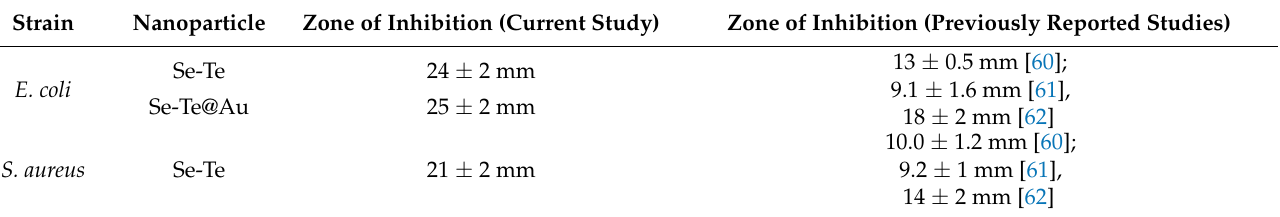
Table 1. A comparison of the anti-bacterial activities in the current study and in previously reported studies.